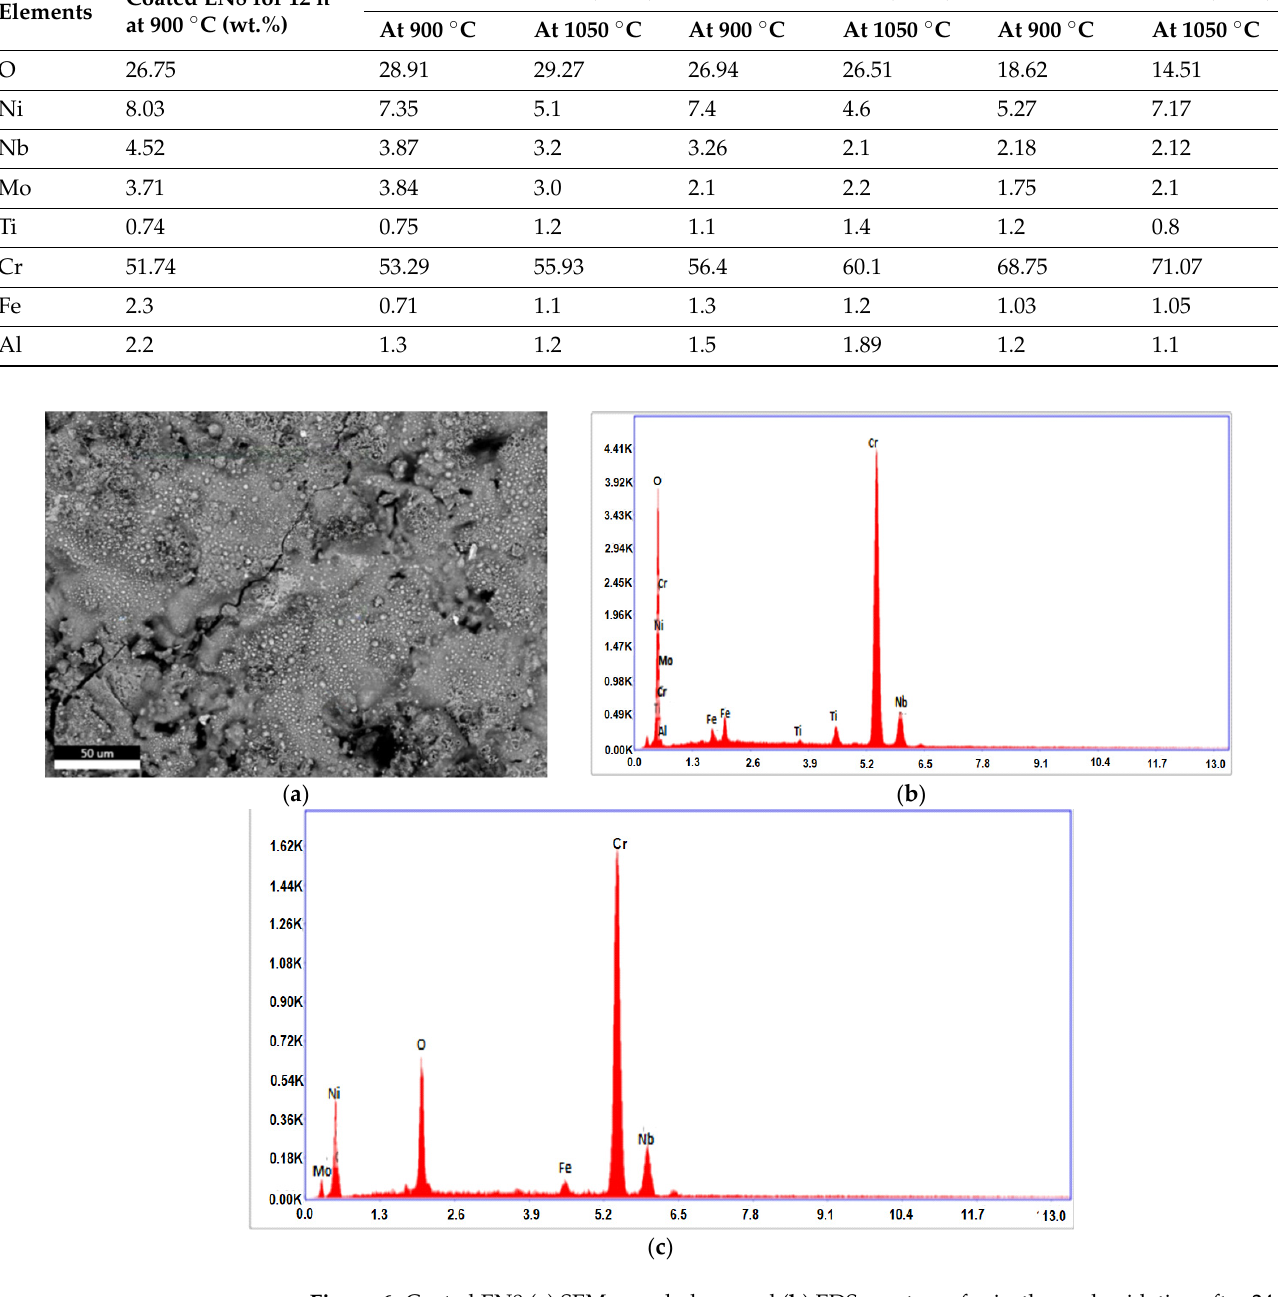
Figure 6. Coated EN8 ( a ) SEM morphology and ( b ) EDS spectrum for isothermal oxidation after 24 h at 1050 °C and ( c ) EDS spectrum at 900 °C. Table 4. EDS Composition of coated EN8 for di ff erent oxidation times and at di ff erent temperatures. Coated EN8 for 12 h Elements